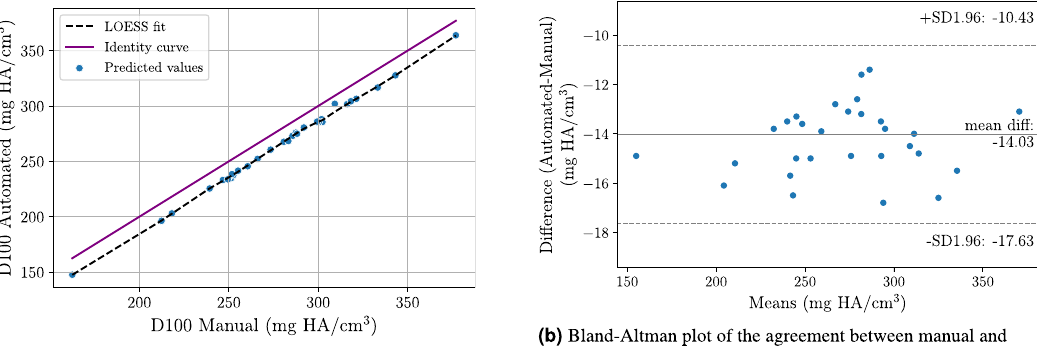
Figure 3. Correlation analysis of the average bone mineral density (D100) comparing the manual segmentations and the network-based segmentations.